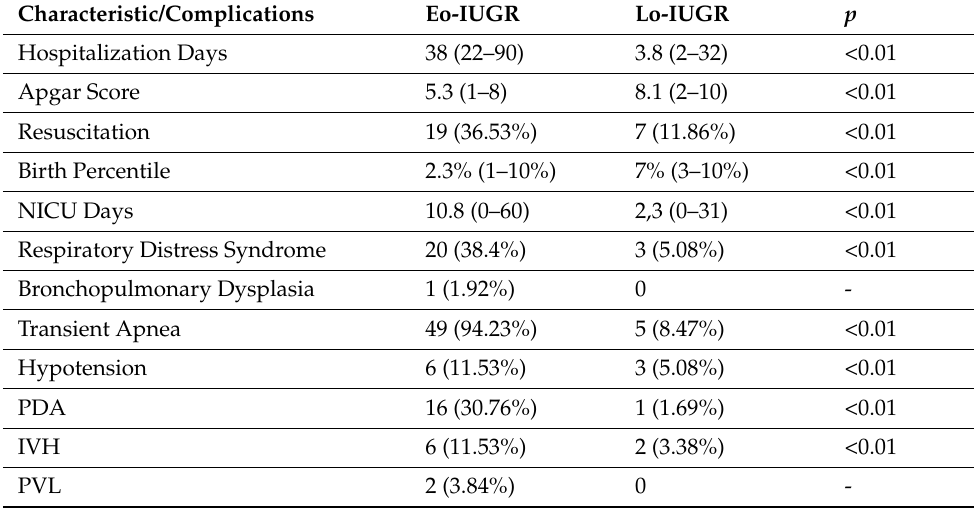
Table 4. Newborn data in pregnancies complicated with